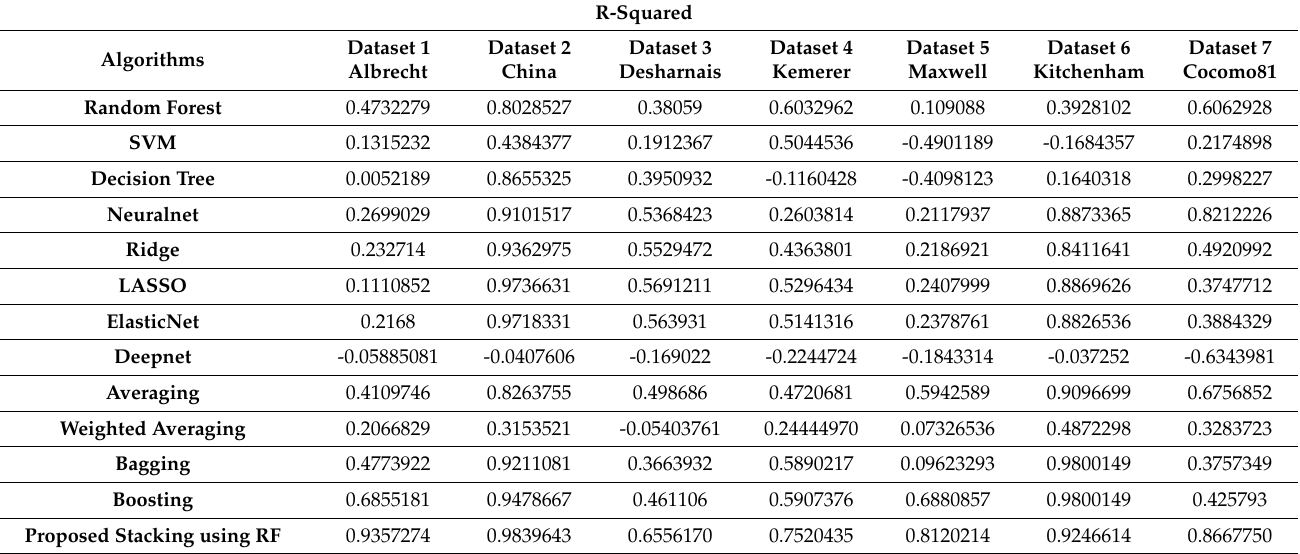
Table 6. Base learners and ensemble techniques vs. R-squared of seven